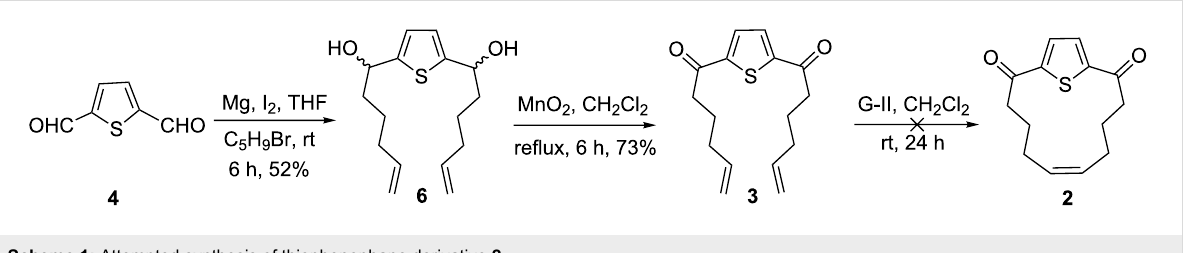
Scheme 1: Attempted synthesis of thiophenophane derivative 2 .